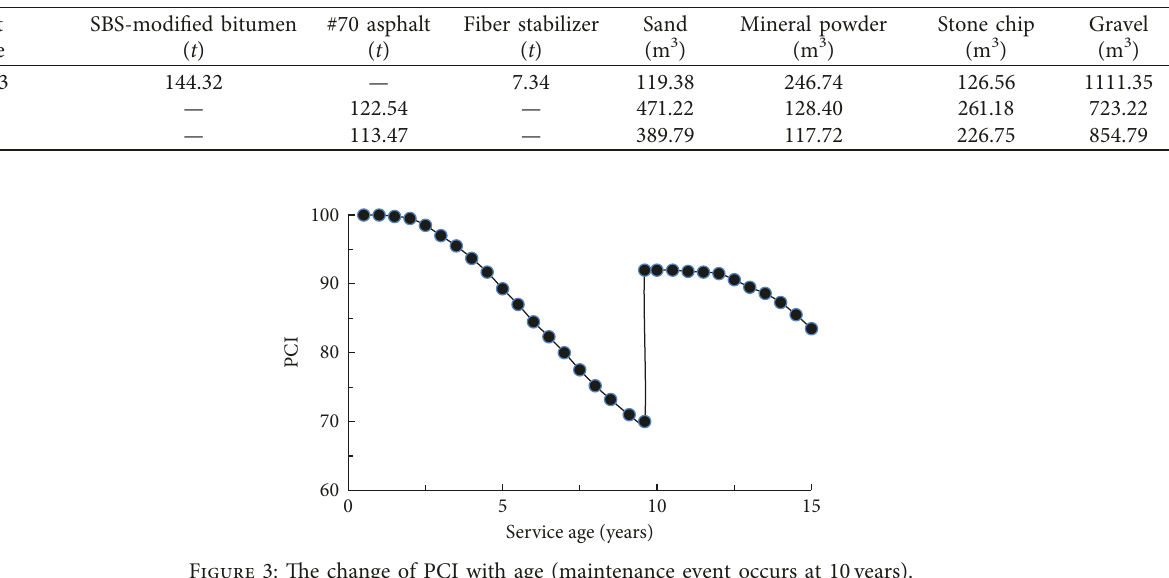
Table 1: Composition of 1000m 3 asphalt mixtures.